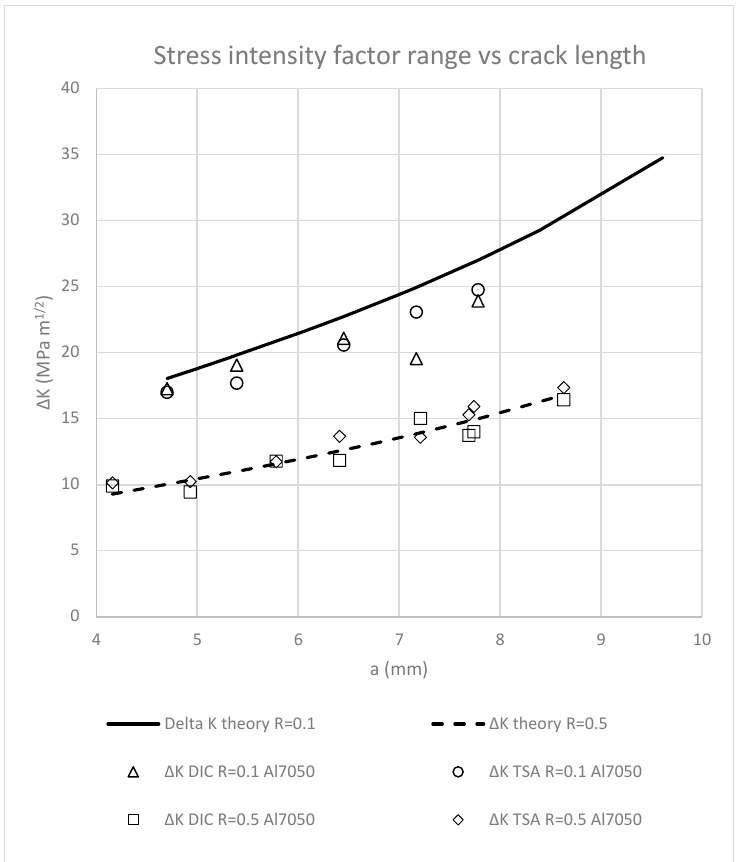
Figure 5. Comparison of the nominal and the effective stress intensity factor ranges obtained by DIC and TSA at different crack lengths for aluminium Al7050-T6 tested at two different stress ratios (0.1 and 0.5).